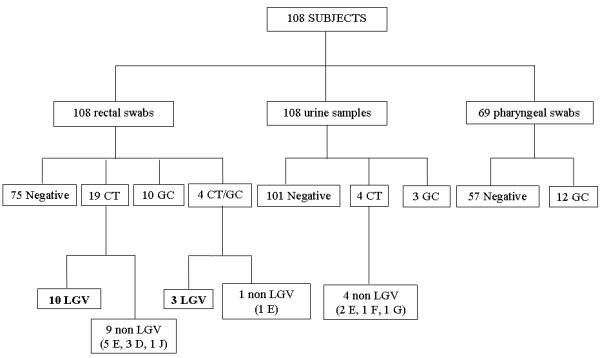
CT and GC testing results. Flowchart of testing of 108 high risk subjects for CT and GC by Versant CT/GC DNA 1.0 Assay. Results obtained by commercial NAAT were confirmed by omp1 and porA in-house PCR assays.